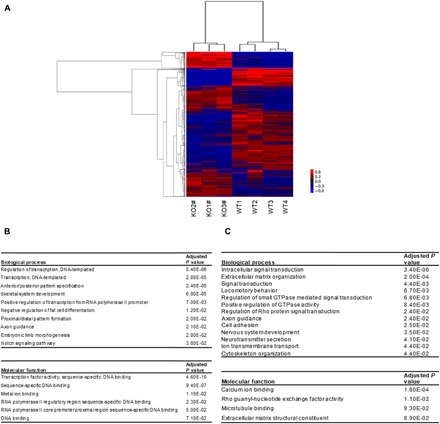
Transcriptomic changes following the deletion of the rs55958994-associated enhancer.(A) Comparison of gene expression in enhancer KO and WT cell lines. The heat map and dendrogram show clustering of differentially expressed genes in three KO and four WT 22Rv1 cell lines. (B) Annotation enrichment analysis of genes significantly down-regulated in KO compared to WT cells (fold change < 1 or 1.5 and adjusted P < 0.1). (C) Annotation enrichment analysis of genes significantly up-regulated in KO compared to WT conditions (fold change > 1.5 and adjusted P < 0.1). GTPase, guanosine triphosphatase.